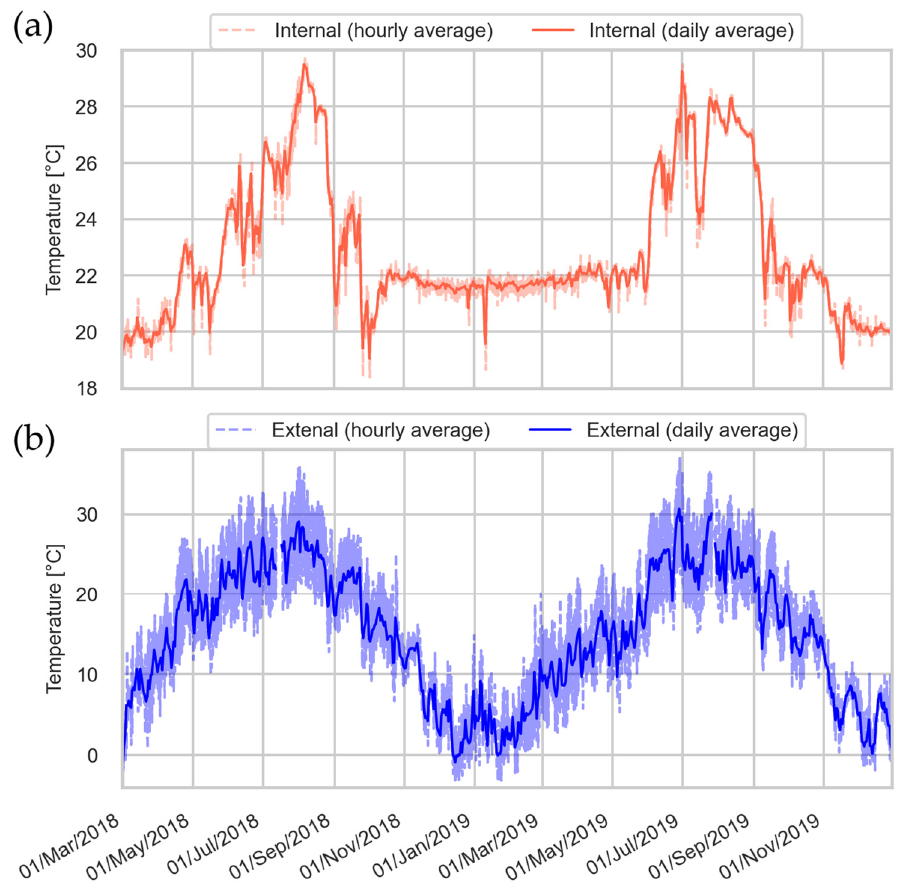
Figure 5. Development of hourly and daily temperatures measured on the inside ( a ) and outside ( b ) of the wall under analysis over a period of 22